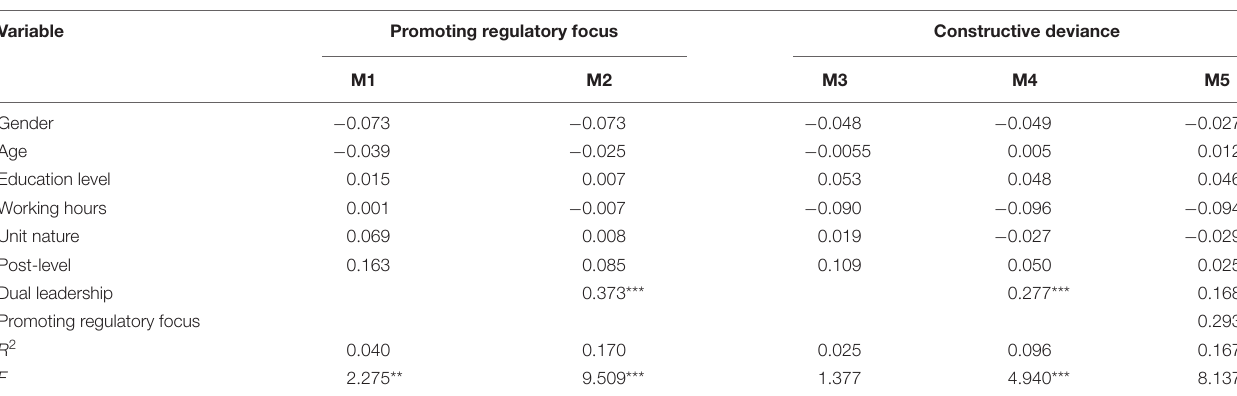
TABLE 4 | Intermediary test of adjustment